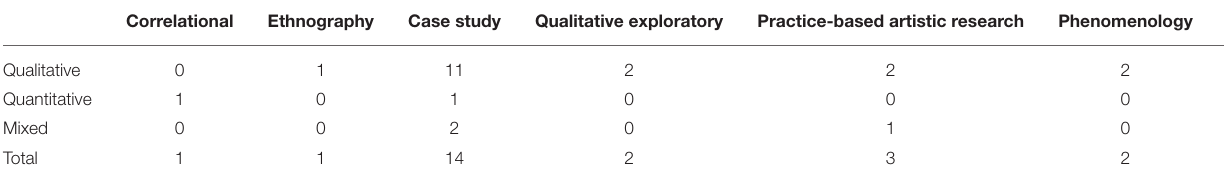
TABLE 7 | Research designs and paradigms.